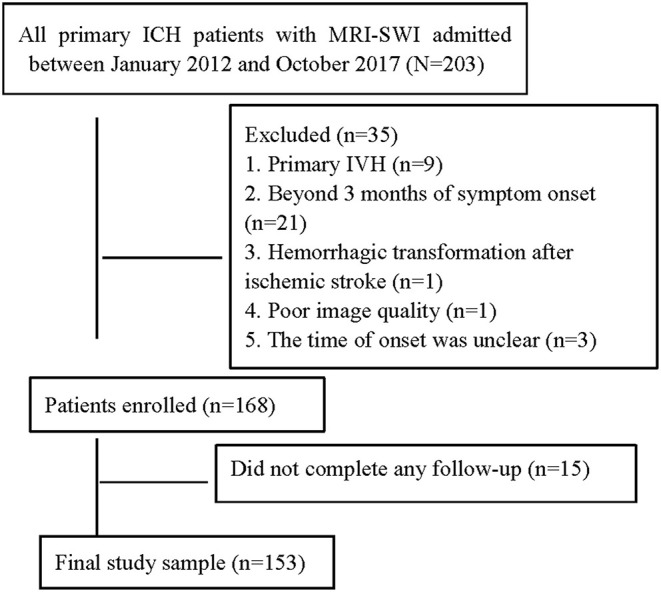
Flow chart of patient selection.